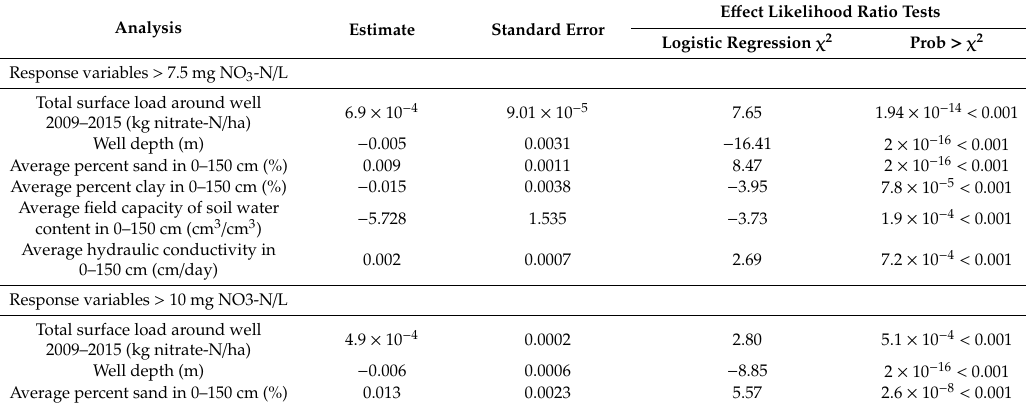
Table 2. Significant predictors for the 7.5 mg NO 3 -N / L and 10 mg NO 3 -N / L threshold evaluated by logistic regression models.